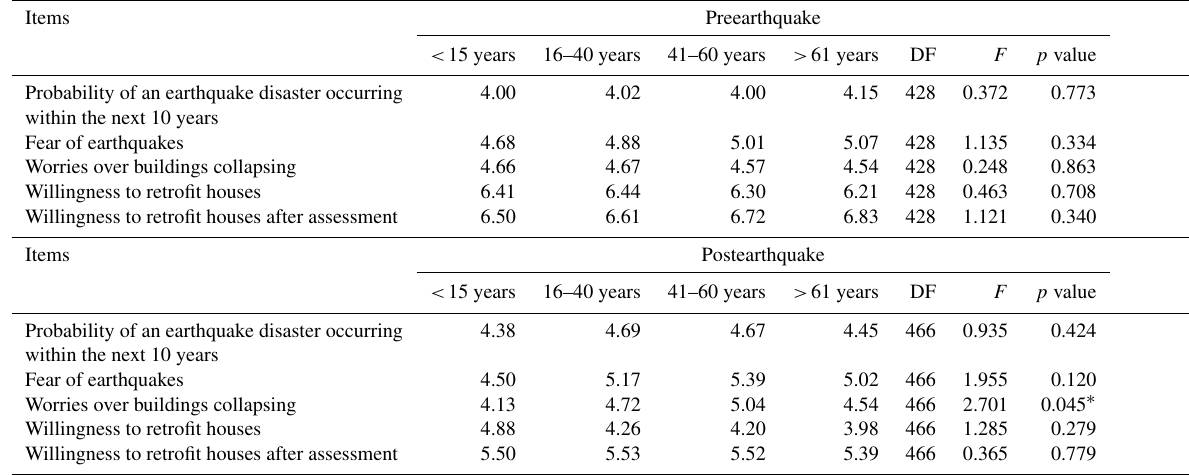
Table 4. p values and means for age.